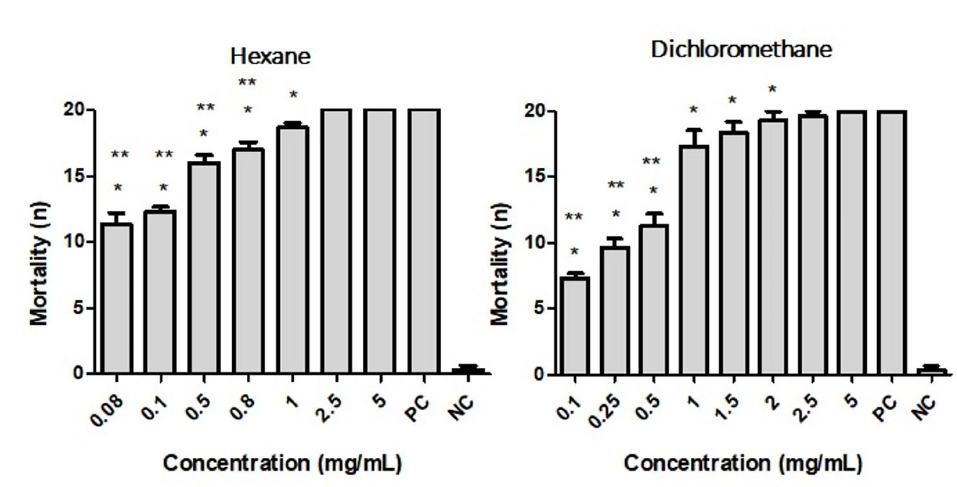
Figure 5. Adulticidal activity – tarsal contact of different concentrations of fractions of Helicteres velutina on Aedes. aegypti mosquito after 48 hours. PC = Positive Control, NC = Negative Control (*) Results significantly different from negative control. (**) Results significantly different from positive